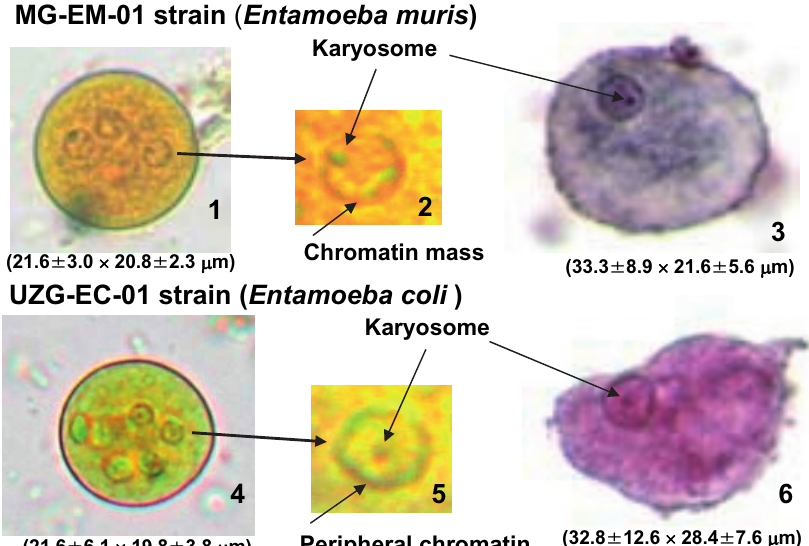
Fig. 2. – Micrographs of cysts and tropho- zoites of Entamoeba muris strain MG- EM-01 and Entamoeba coli strain UZG- EC-01. 1 and 4, cysts of MG-EM-01 (1) and UZG-EC-01 (4) strains stained with Lugol’s iodine solution (Lugol). 2 and 5, nuclei of MG-EM-01 (2) and UZG-EC-01 (5) strains stained with Lugol. 3 and 6, trophozoites of MG-EM-01 (3) and UZG- EC-01 (6) strains stained with Kohn’s chlo- razol black E (Gleason et al ., 1965).